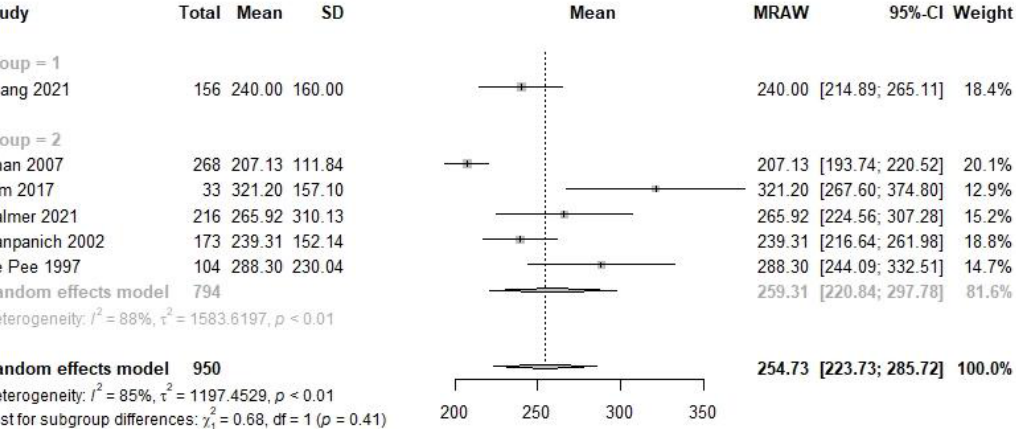
Figure 5. Forest plot of late mature human milk VA concentration and subgroup analysis between Chinese and non-Chinese samples.